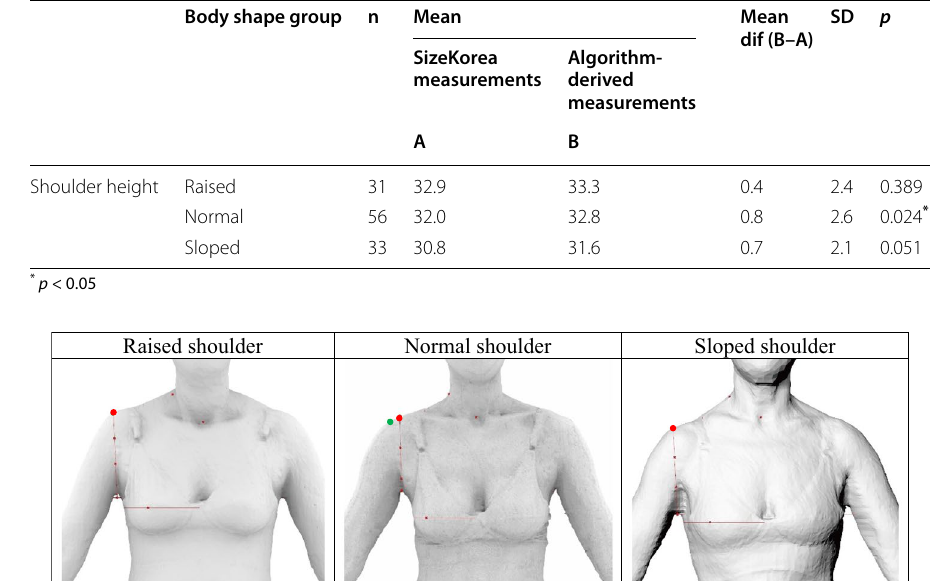
Table 7 The t -test results of the shoulder height of the shoulder shape groups (Unit: cm)